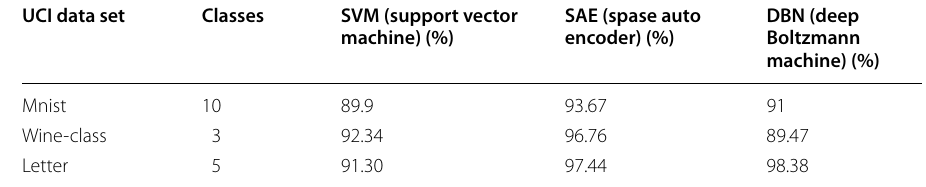
Table 3 Algorithm performance comparison based on different data sets UCI data set